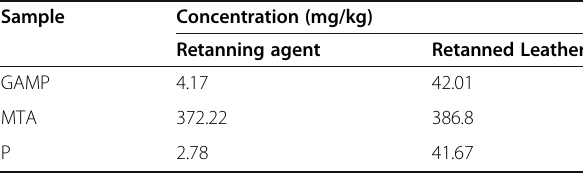
Table 3 The free formaldehyde contents of different retanning agents and corresponding retanned leathers